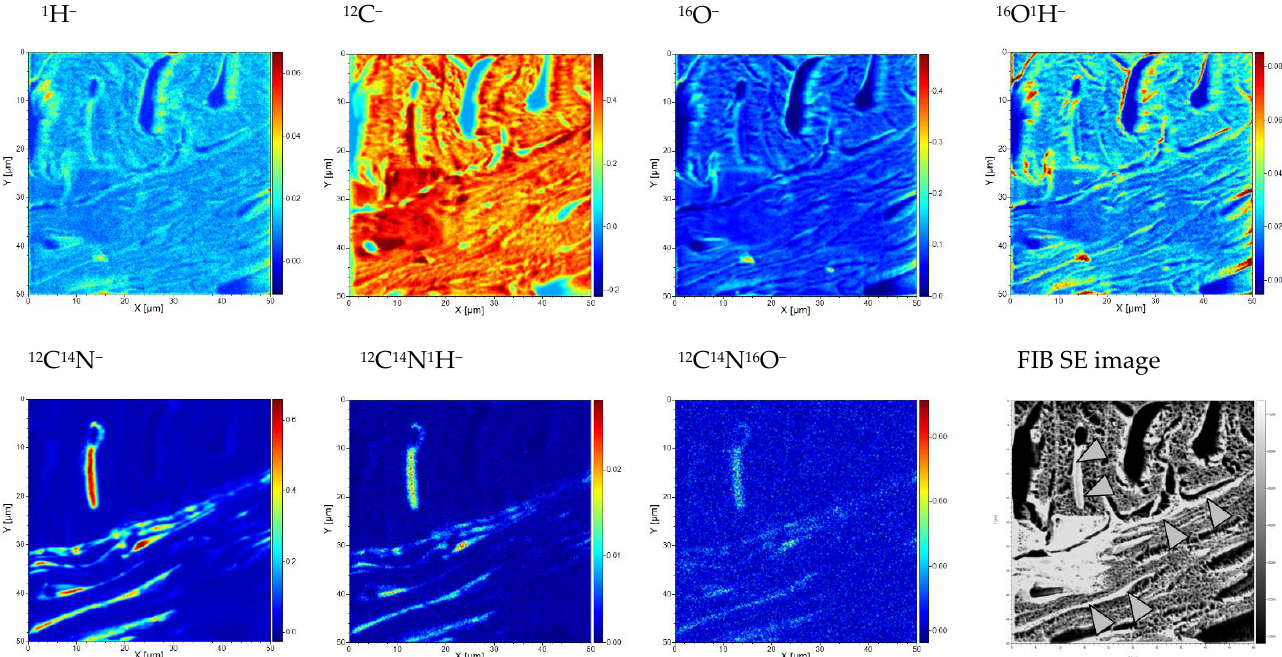
Figure 4. Elemental distribution maps of the selected isotopes and their molecular clusters for a spruce particle. The element exponent indicates a detected mass of ions or their clusters used for displaying the maps. Brighter regions in the FIB SE image refers to pMDI (marked); see Figure 2B for the selected area of interest SEM.